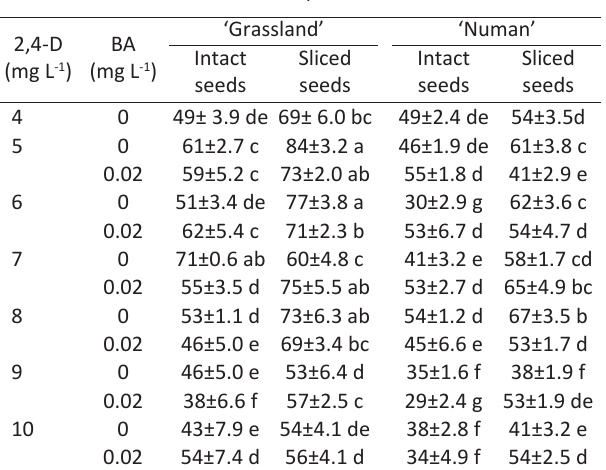
Table 1 - Interaction of different concentrations of 2,4-D and BA on callus induction of intact and sliced caryopses in two cultivars of Lolium perenne L.